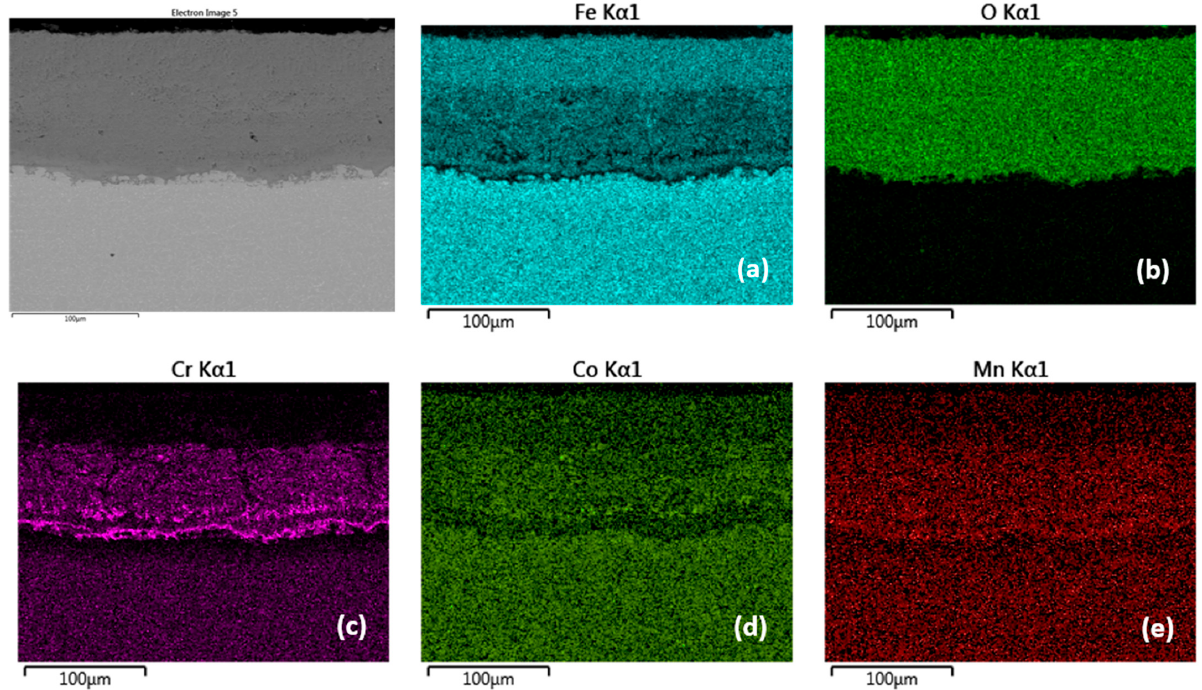
Figure 11. Cross-sectional SEM morphologies and EDS spectra analysis ( a – e ) of oxide films after oxidation for 2000 h, steel MarBN at 650 °C.